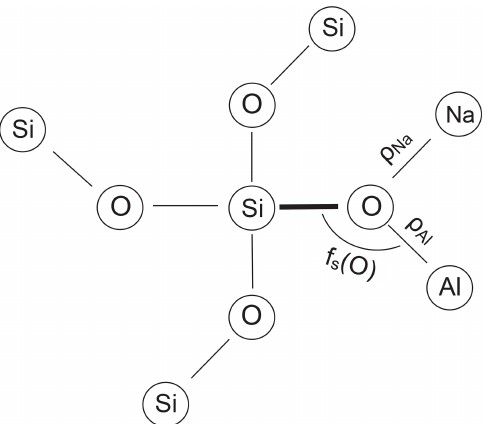
Figure 2. Schematic drawing of the atomic environment of a T–O bond (heavy